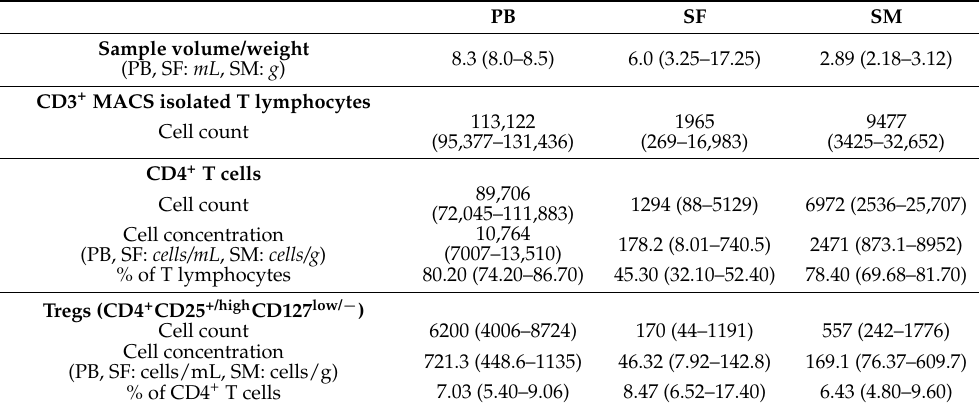
Table 2. T cell infiltration in peripheral blood, synovial fluid and synovial membrane. PB SF SM Sample volume/weight (PB, SF: mL , SM: g